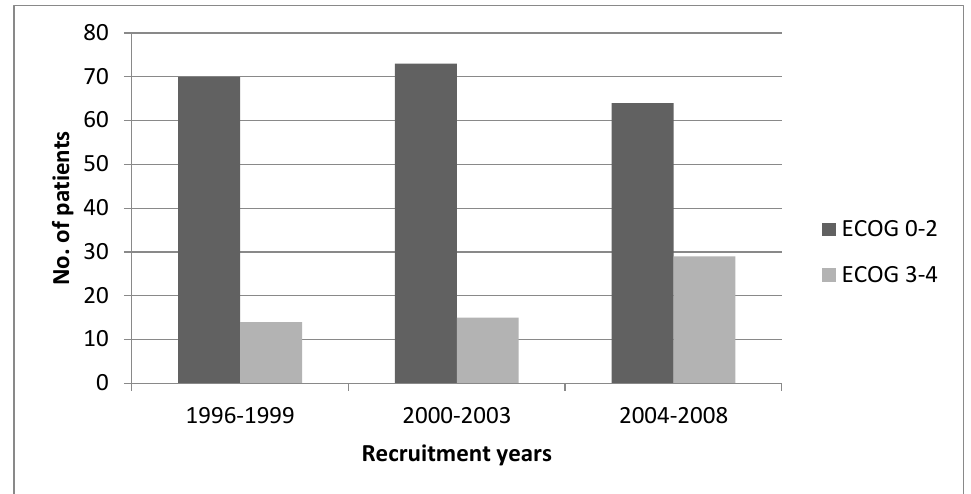
Figure 2. Performance status in patients with haematologic malignancies at diagnosis in 3 periods of time.